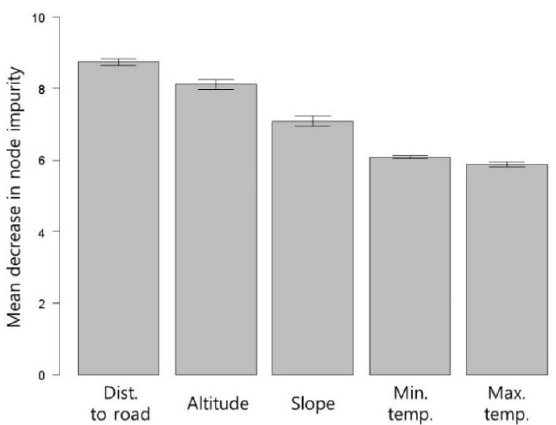
Figure 7. Relative importance of independent variables in the RF model for projecting presence or absence of Metcalfa pruinosa . Importance was calculated using node impurity in the RF model. Error bars indicate averages and standard errors. Dist. to road: distance to road, Min. temp.: minimum temperature in January, and Max. temp.: maximum temperature in July.